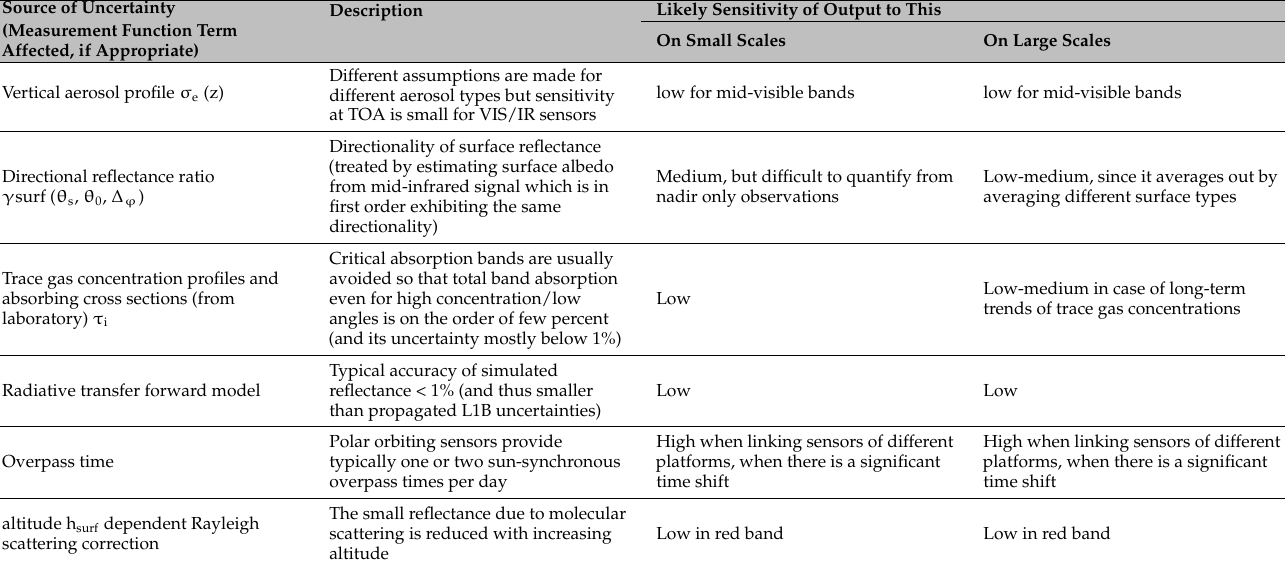
Table 6. Effects which are regarded as minor or